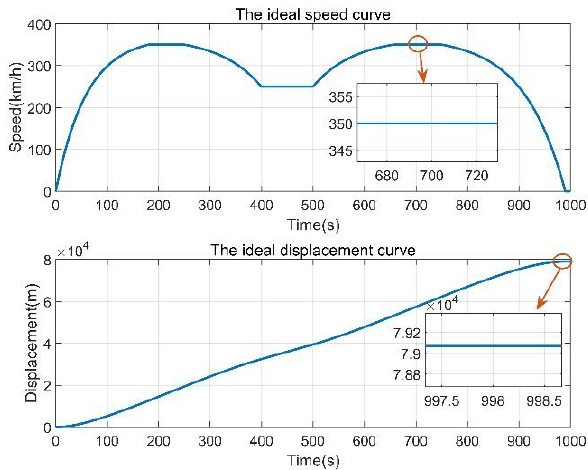
Figure 4. Ideal speed and displacement curve.